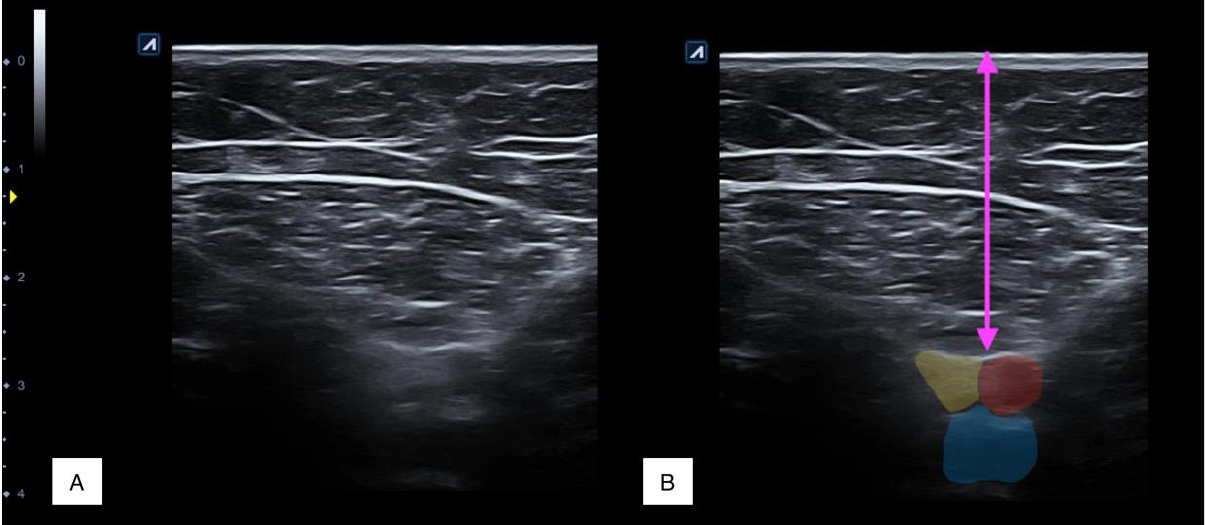
Figure 2. Ultrasound imaging of sartorius muscle at the proximal third ( A ). The pink arrow indicates the distance between the skin and the deep sartorius fascia limit. The femoral bundle is colored in yellow (nerve), red (artery), and blue (vein) ( B ).